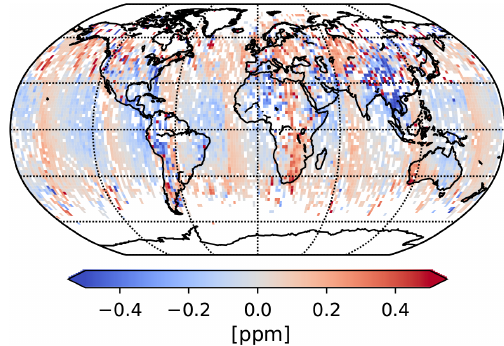
Figure 14. Global difference between v8 and v9 (v9–v8) bias- corrected X CO for April 2016. Only soundings that passed the v8 2 and v9 filtration are taken into account. A mean bias of 0.15ppm (mainly introduced by the different global scaling factors for v8 and v9) is subtracted. Data are aggregated into 2 ◦ × 2 ◦ latitude– longitude square